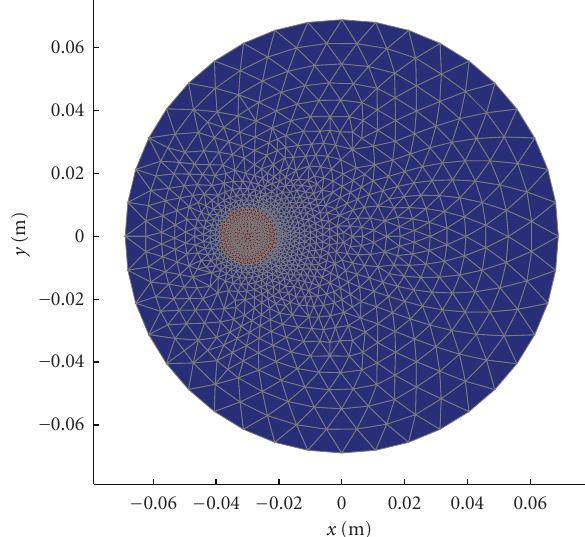
Figure 5: Soft prior mesh for the microwave image reconstruction comprised of 1107 nodes and 2092 triangular